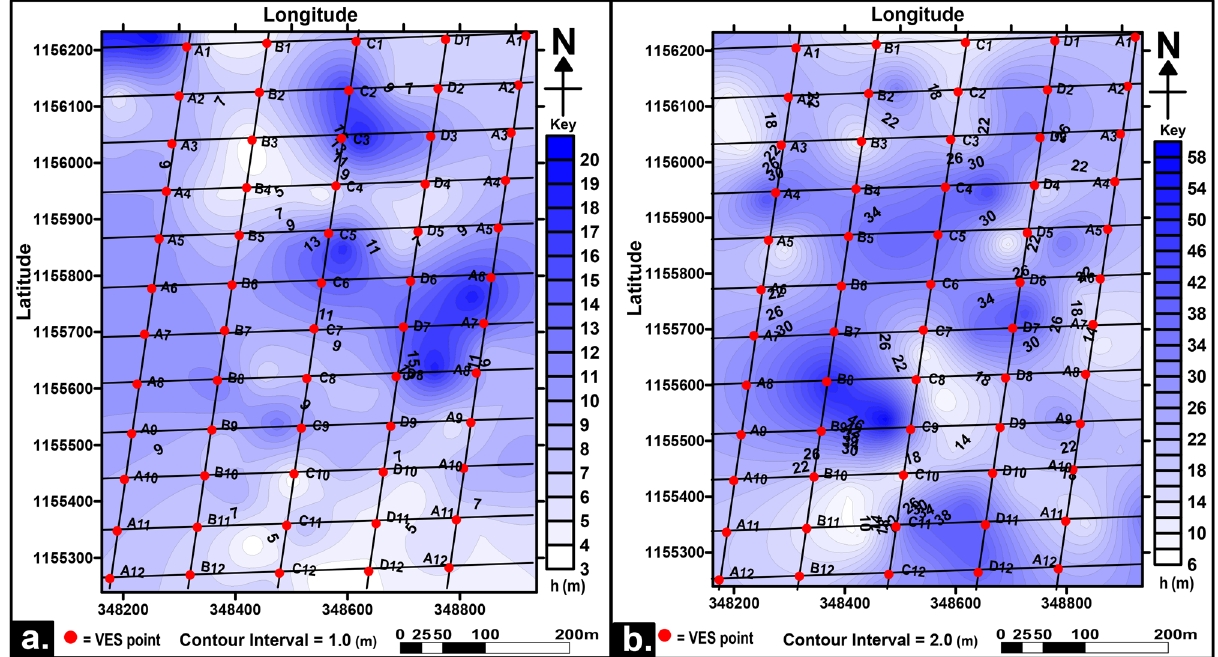
Fig. 6 Aquifer potential parameters showing a the overburden thickness overlain the water-bearing unit and b the thickness of the regional aquifer (water-bearing)